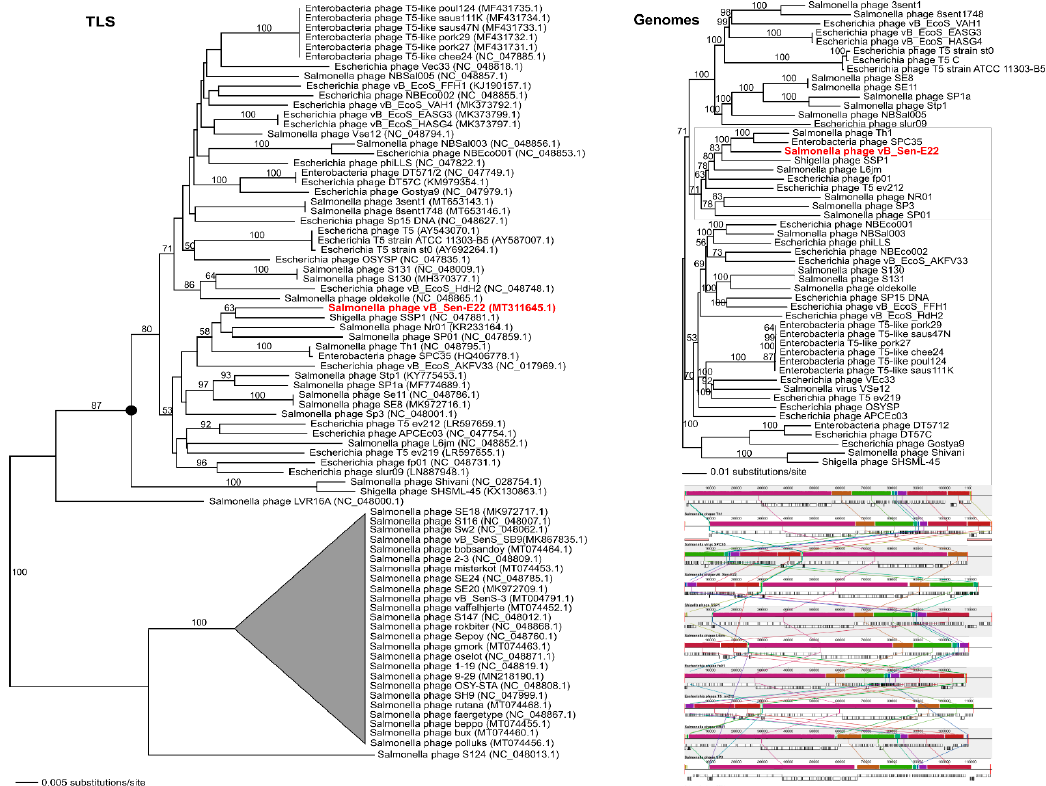
Figure 9. Neighbour-joining phylogenetic tree showing the phylogenetic position of phage vB_Sen-E22 (in red color) within Tequintavirus, based on the sequence coding for terminase large subunit (TLS), as well as on the whole-genome analysis (Genomes). The reference sequences were collected from the NCBI database. The tree was constructed using PAUP *. Bootstrap value > 50%, calculated based on 1000 resamplings, is shown above branches.